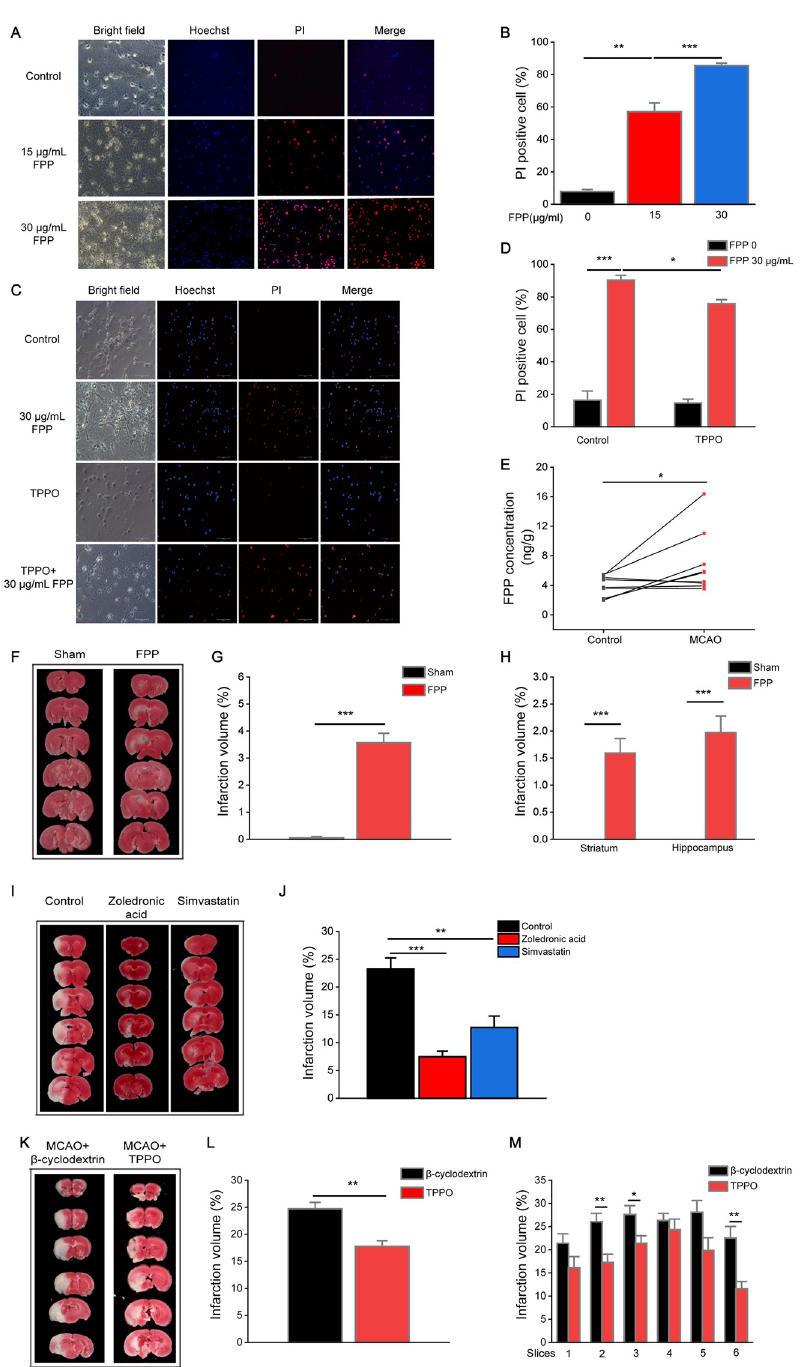
Fig 7. FPP accumulates in the brain of MCAO mice and FPP-TRPM2 axis is involved in mouse brain ischemic injury. (A) Neurons stained with Hoechst (blue) and PI (red). Bar denotes 100 μ m. (B) Quantification of Hoechst–PI staining. Bars denote mean ± SEM. Nine fields from 3 independent experiments were evaluated. (C, D) TPPO effects on FPP-induced neuronal death. (C) Representative images under confocal microscopy, the scale bar is 100 μ m. (D) Quantification of PI-positive cells versus Hoechst positive cells. Bars denote mean ± SEM. Nine fields from 3 independent experiments were evaluated. (E) FPP concentration in brains after 90 minutes MCAO and 24-hour reperfusion and brains without MCAO. One line means 1 mouse. ( n = 9) (F) Representative images of serial coronal brain sections stained with TTC after FPP injection. (G, H) Statistical result of the whole brain infarction volume (G) or infarction volume of striatum and hippocampus (H) after FPP injection. Bars denote mean ± SEM. ( n = 9 for